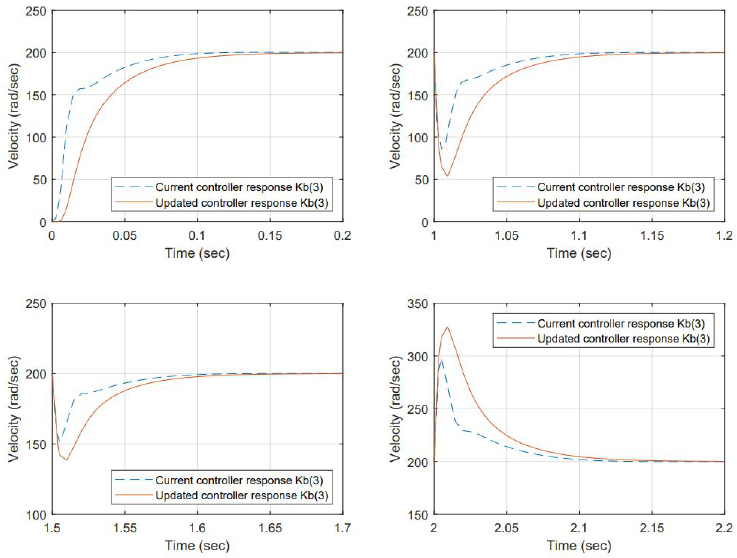
Figure 16. System response to a Back EMF change ( K b = 0.045)—sample 5. The dynamic response at initial conditions and load accepts and load rejects achieves 63% of the reference at approximately 0.025 s, the steady-state error is 0% at the stable point after 0.15 sec. In terms of performance, the proposed gains have room for improvement to reduce overshoot and increase speed